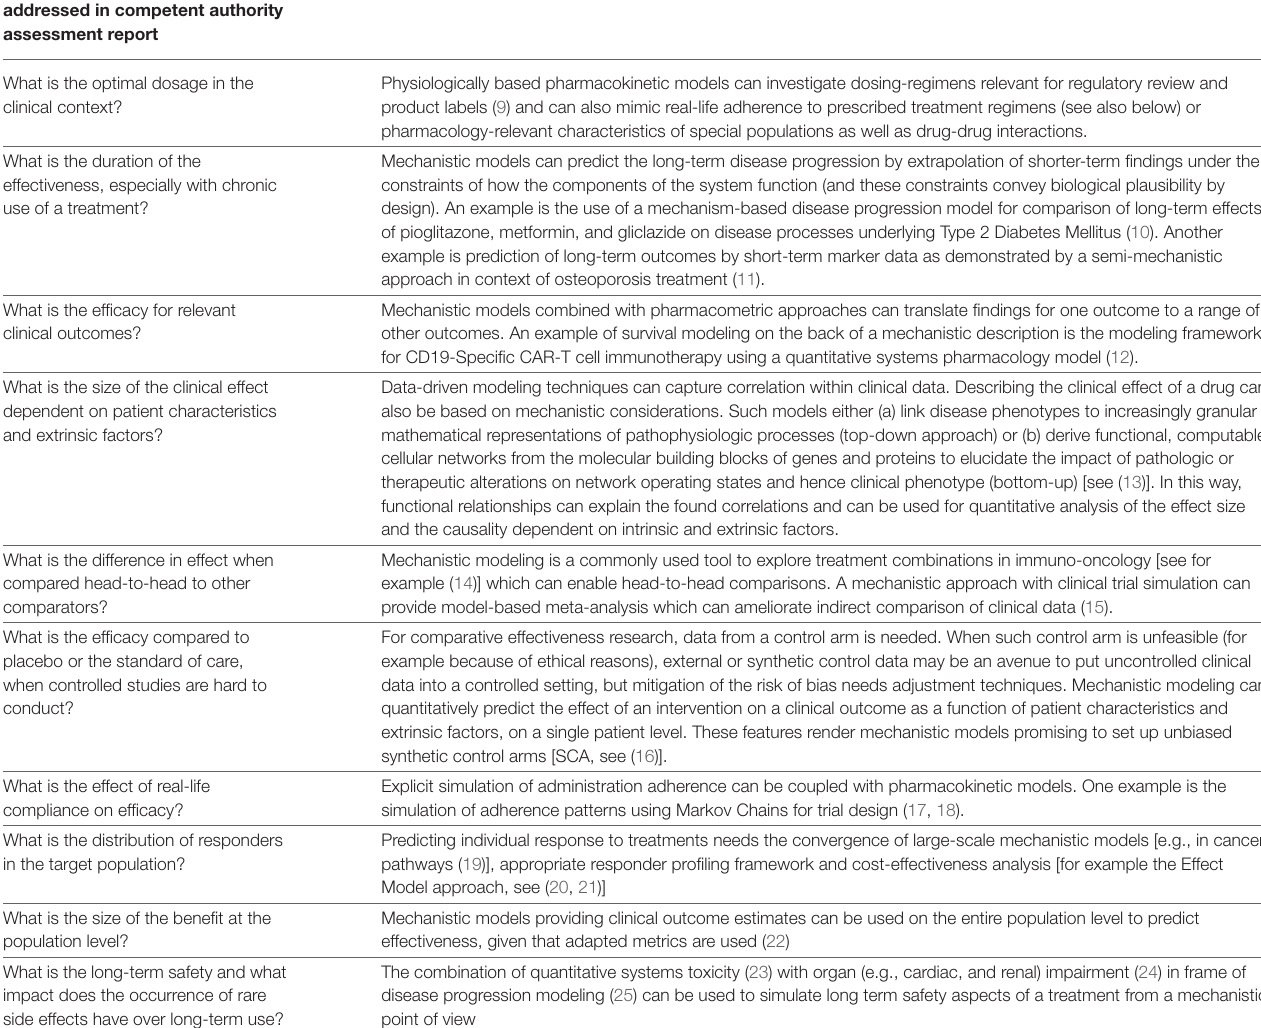
TABLE 1 | Examples of how published (mechanistic) models rooted in the clinical development space (model informed drug development, MIDD) could address uncertainties in new medicinal product assessment reports. Uncertainty not completely addressed in competent